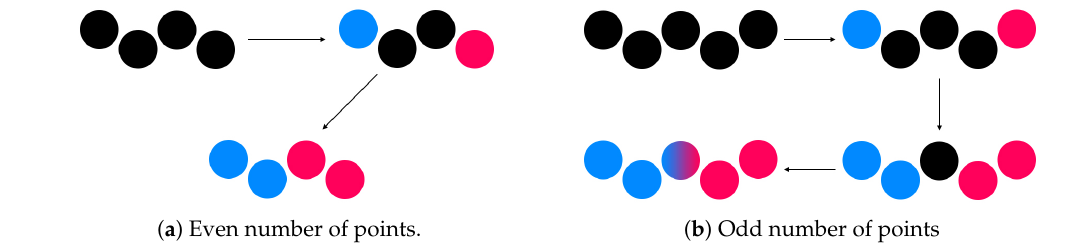
Figure 5. Cluster split process example for clusters that contain between four and six points. ( a ): split process with even number of points; ( b ): split process with odd number of